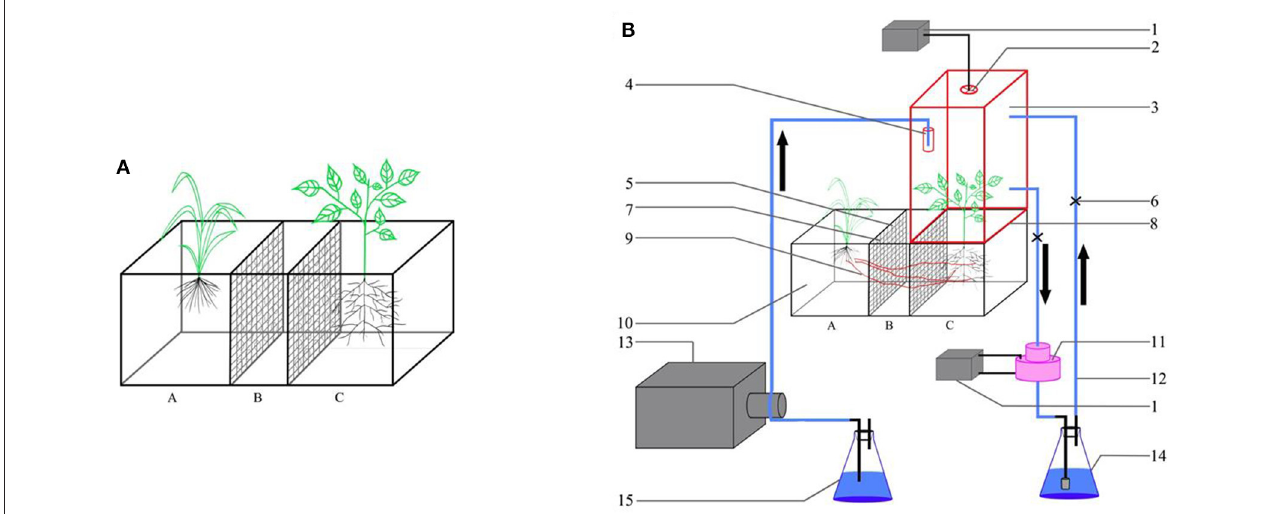
FIGURE 1 | Schematic diagram of three compartment PVC box (A) and 13 C labeling (B) . 1. Battery; 2. Electric Fan; 3. Sealed container; 4. Na 13 2 CO 3 ; 5. Nylon nets ( ϕ = 30 µ m); 6. Clamp; 7. Hole; 8. Liquid seal rough; 9. Hyphae; 10. Three compartments PVC boxes; 11. Pump; 12. Latex tube; 13. Peristaltic pump; 14. NaOH solution (0.4 mol/L); 15. H 2 SO 4 solution (0.36